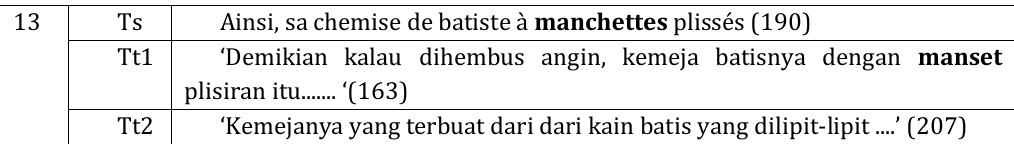
Tableu 13 L’adaptation orthographique